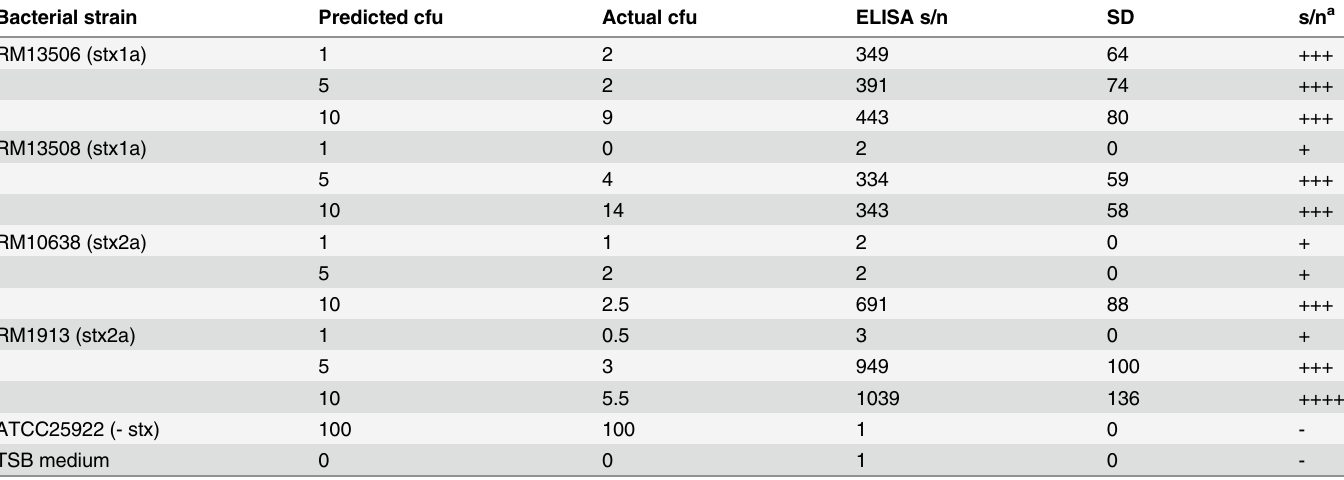
Table 3. Detection of Stx in group beef samples spiked with STEC strains. Bacterial strain